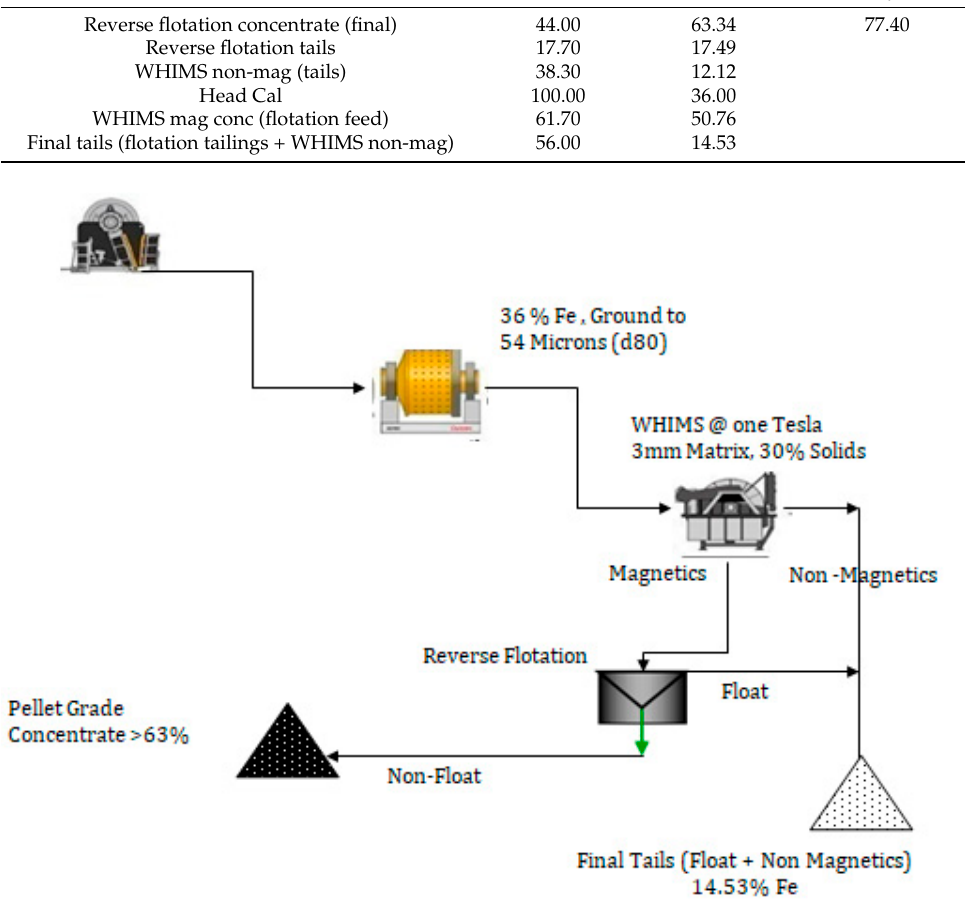
Figure 7. Final process flowsheet for processing BHQ. Table 10. Final test with WHIMS followed by flotation of WHIMS concentrate. Table 11. The characteristics of concentrate of the final process.